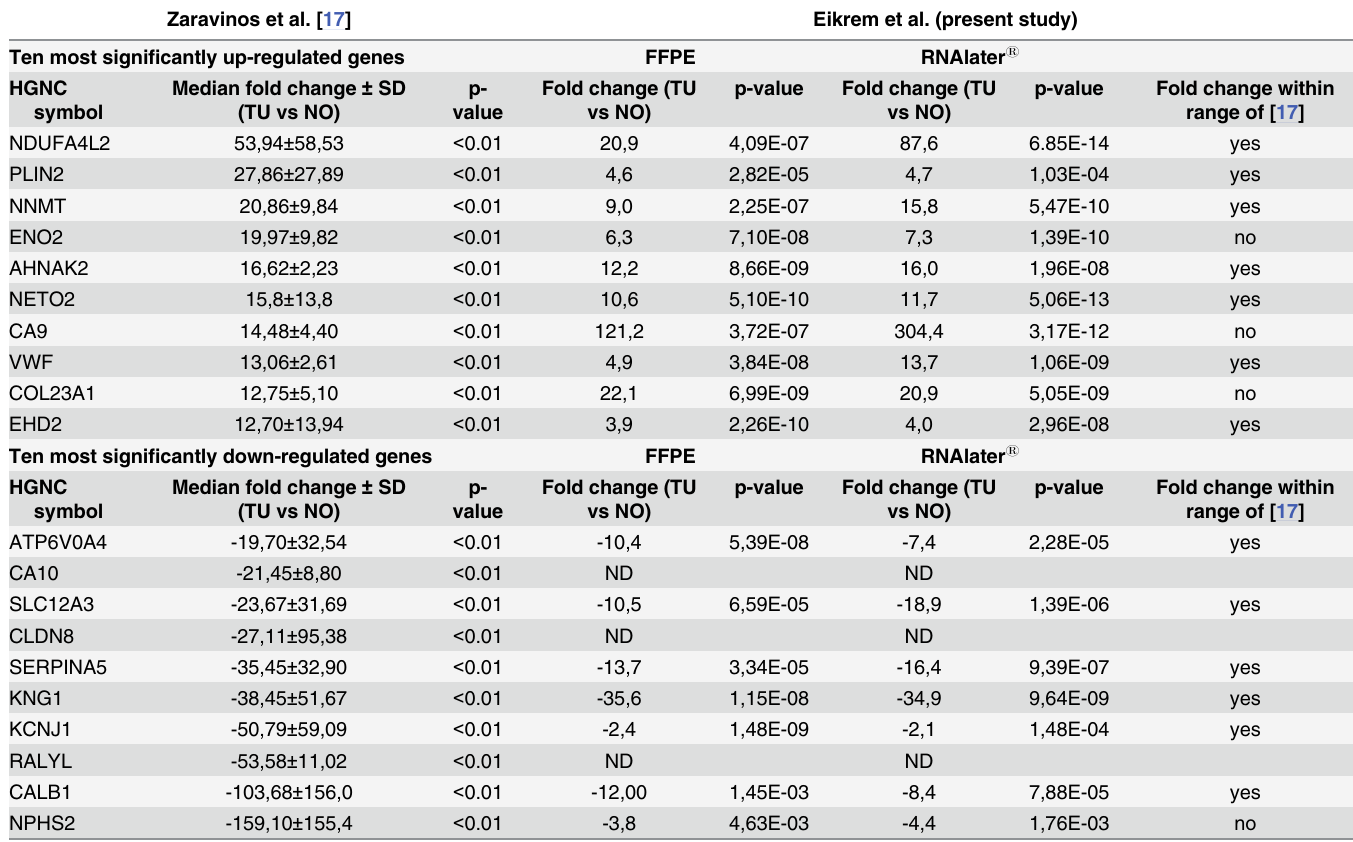
Table 4. Comparison of our gene expression data with data from literature [17]. Twenty genes with smallest p-values and largest absolute fold changes in a meta-analysis of five microarray studies are compared to the corresponding genes and their fold changes and p-values of the NGS datasets. The median fold changes and standard deviations for the meta-analysis are presented. All shown genes were differentially expressed in only 2 or 3 microarray datasets. Large standard deviations indicate a large spread of values in the individual microarray studies. 17 of the 20 genes were found differentially expressed in both NGS datasets, 13 of these with fold changes within the fold change range of the microarray meta-analysis. ND : not detected , did not pass initial expression filter . Zaravinos et al.